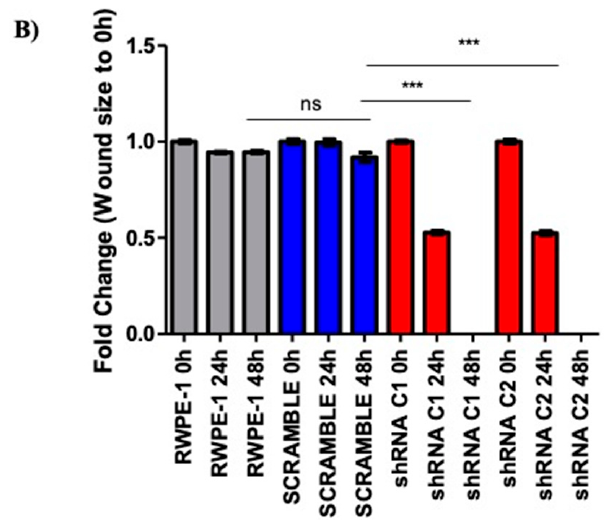
Figure 4. Reduction of SELENOF increases the migration of RWPE-1 cells in a scratch assay. ( A ) Representative images were captured at 0 h, 24 h, and 48 h for RWPE-1, RWPE-1 scramble, and 2 clones of RWPE-1 shRNA SELENOF cells. ( B ) Quantification of the scratch from three independent experiments are shown. The images were captured using the EVOS FL Auto Imaging system (ThermoFisher) and the width was measured using ImageJ. Data are represented as the mean ± SEM, ns, not significant, n = 3 and a two-tailed paired t -test was used to determine statistical significance, *** p < 0.001.